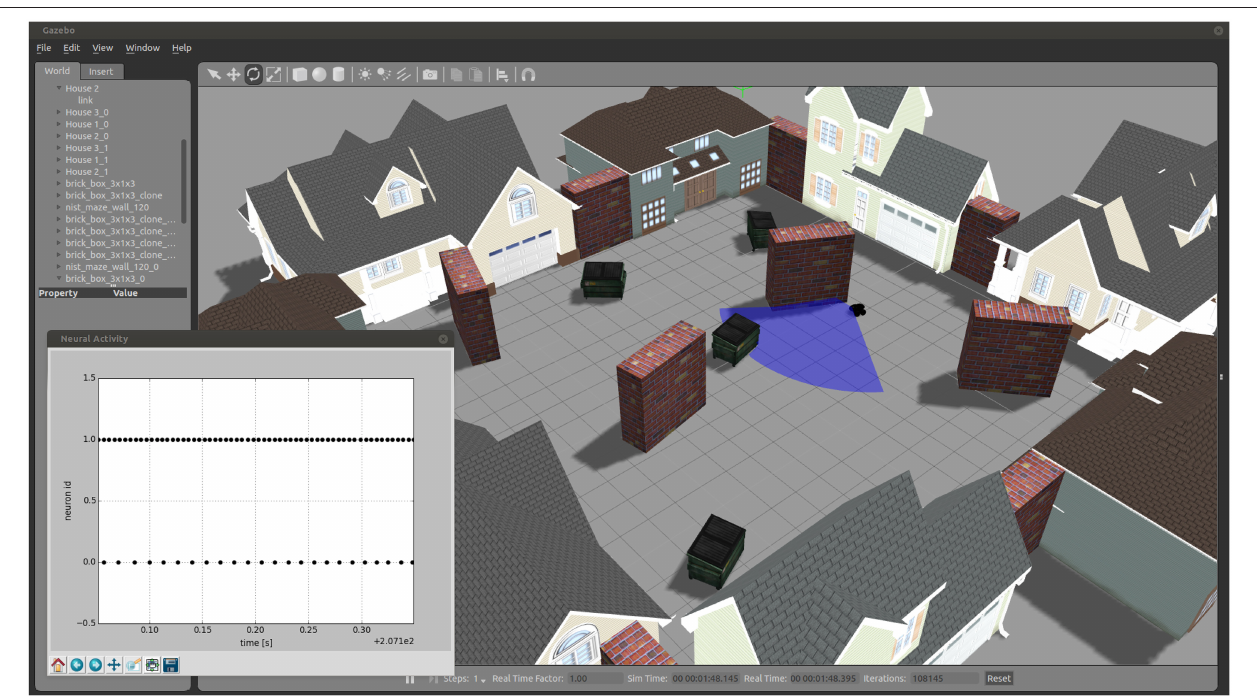
FIGURE 6 | A Braitenberg Vehicle simulated in Gazebo, controlled by simulated neurons in NEST with the use of the ROS-MUSIC toolchain. The main figure shows a view of the simulated environment and agent, the sensor range depicted as a blue shaded area. The inset shows the spiking activity of the two controlling